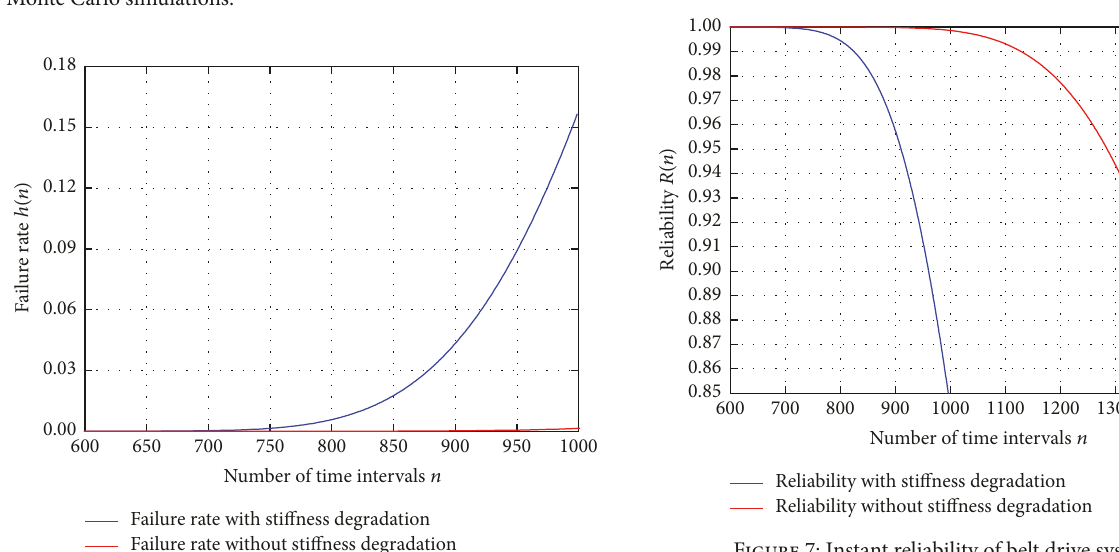
Figure 7: Instant reliability of belt drive